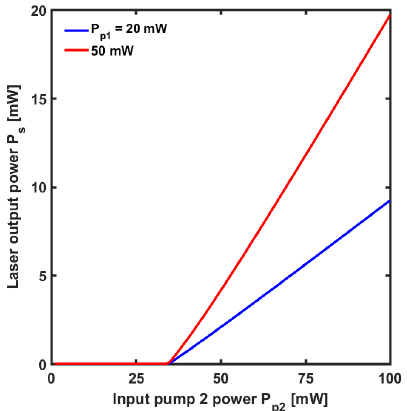
Figure 10. Characteristics of the dysprosium doped chalcogenide fiber laser pumped with quantum cascade lasers (QCLs). Figure adapted from